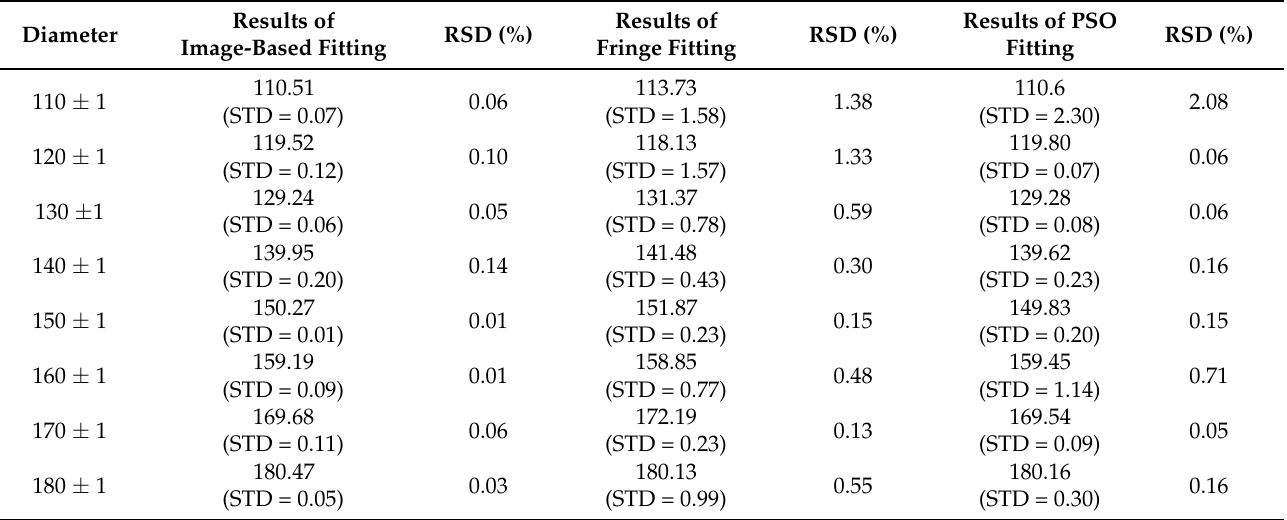
Table 3. Comparison of different methods * (unit: µ